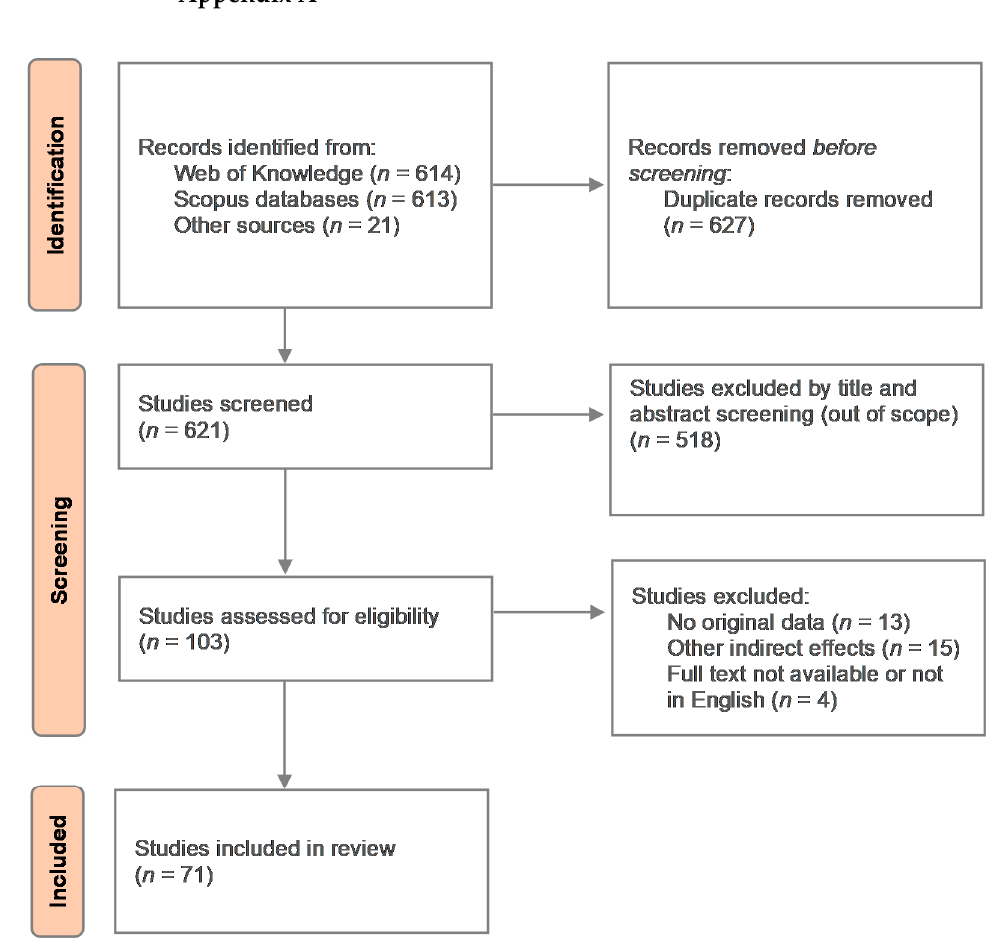
Figure A1. PRISMA flow chart of literature search and selection